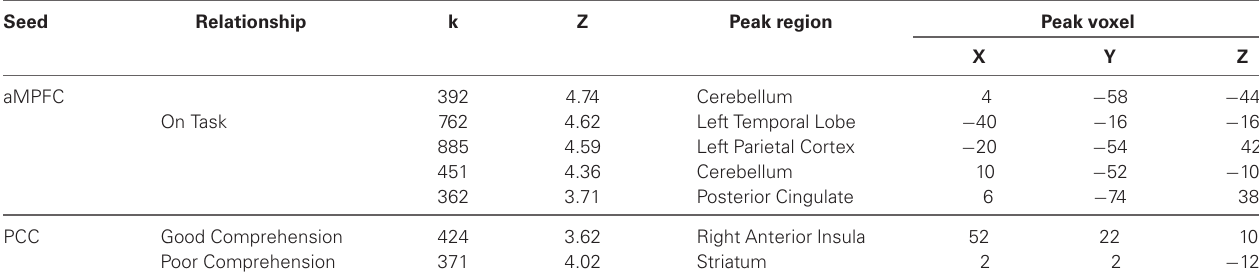
Cluster forming threshold was set at p < 0.01 and significant clusters were determined using topological FDR (q-value <